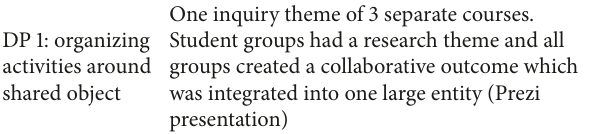
Table 2: An example of activities describing